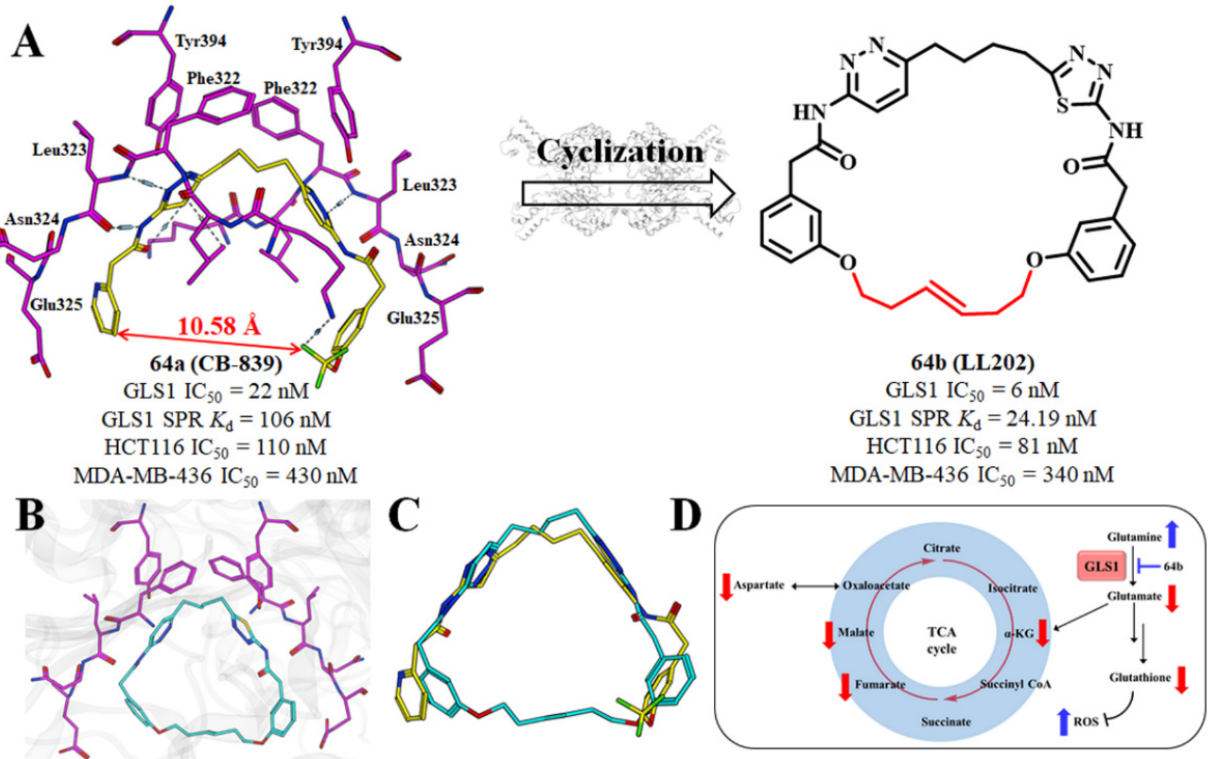
Figure 21. ( A ) Schematic representation of the rational design of GLS1 macrocyclic inhibitor scaffold. ( B ) A close-up view of the interactions of 64b in GLS1 allosteric binding pocket (PDB ID: 6LOX). ( C ) Overlay of X-ray-based structure of 64a (yellow, PDB: 5HL1) and 64b (cyan, PDB: 6LOX). ( D ) The change of intracellular metabolite levels induced by 64b .